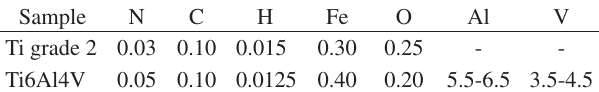
Table 1. Composition/wt. (%) of Ti and Ti6Al4V alloy (maximum values). Sample